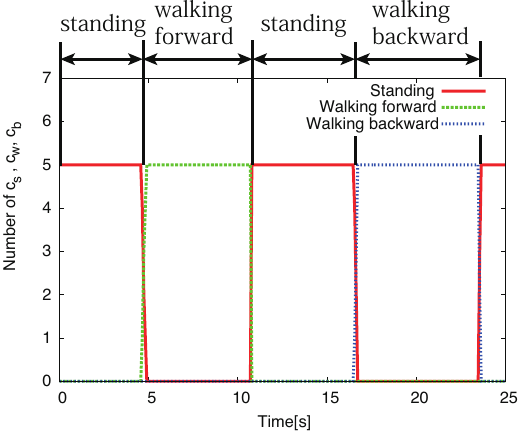
Figure 7. Results of motion estimation based on k-nearest neighbor